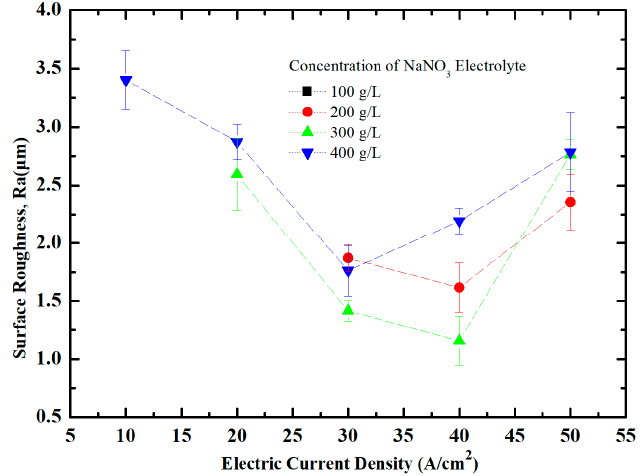
Figure 17. Surface roughness of workpiece at different current density.